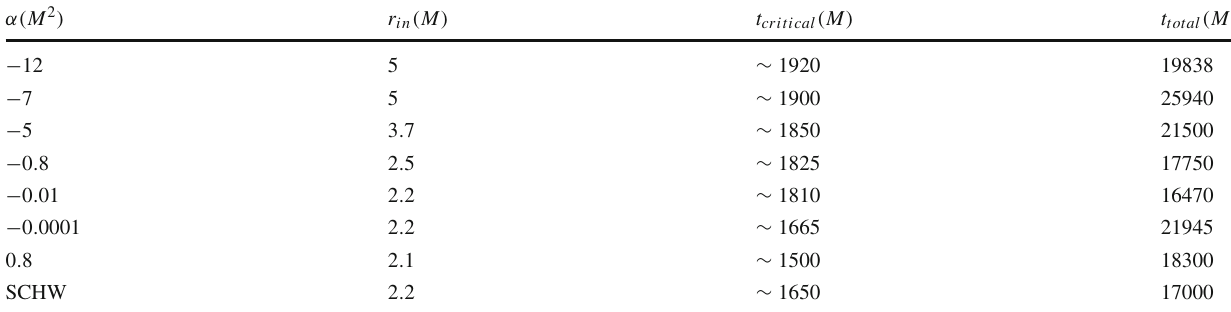
Table 1 The physical parameters and times: Gauss–Bonnet coupling constant α , the inner boundary location of computational domain r in , time to need to create a fully formed shock cone t critial (required time α( M 2 ) r